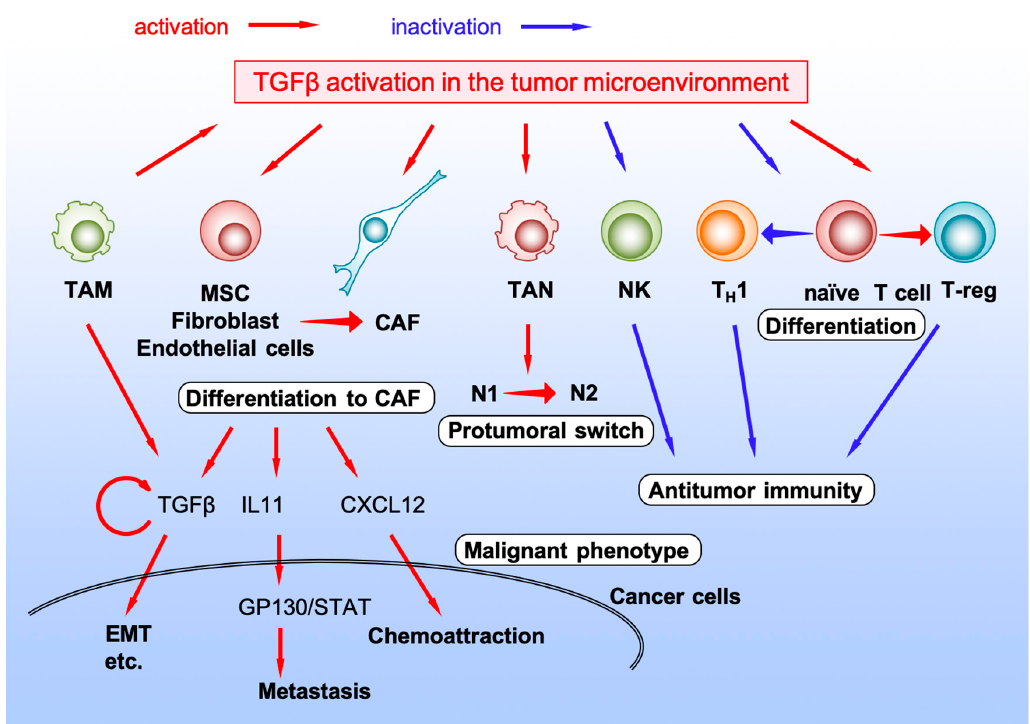
Figure 3. TGF- β activation in the tumor microenvironment.